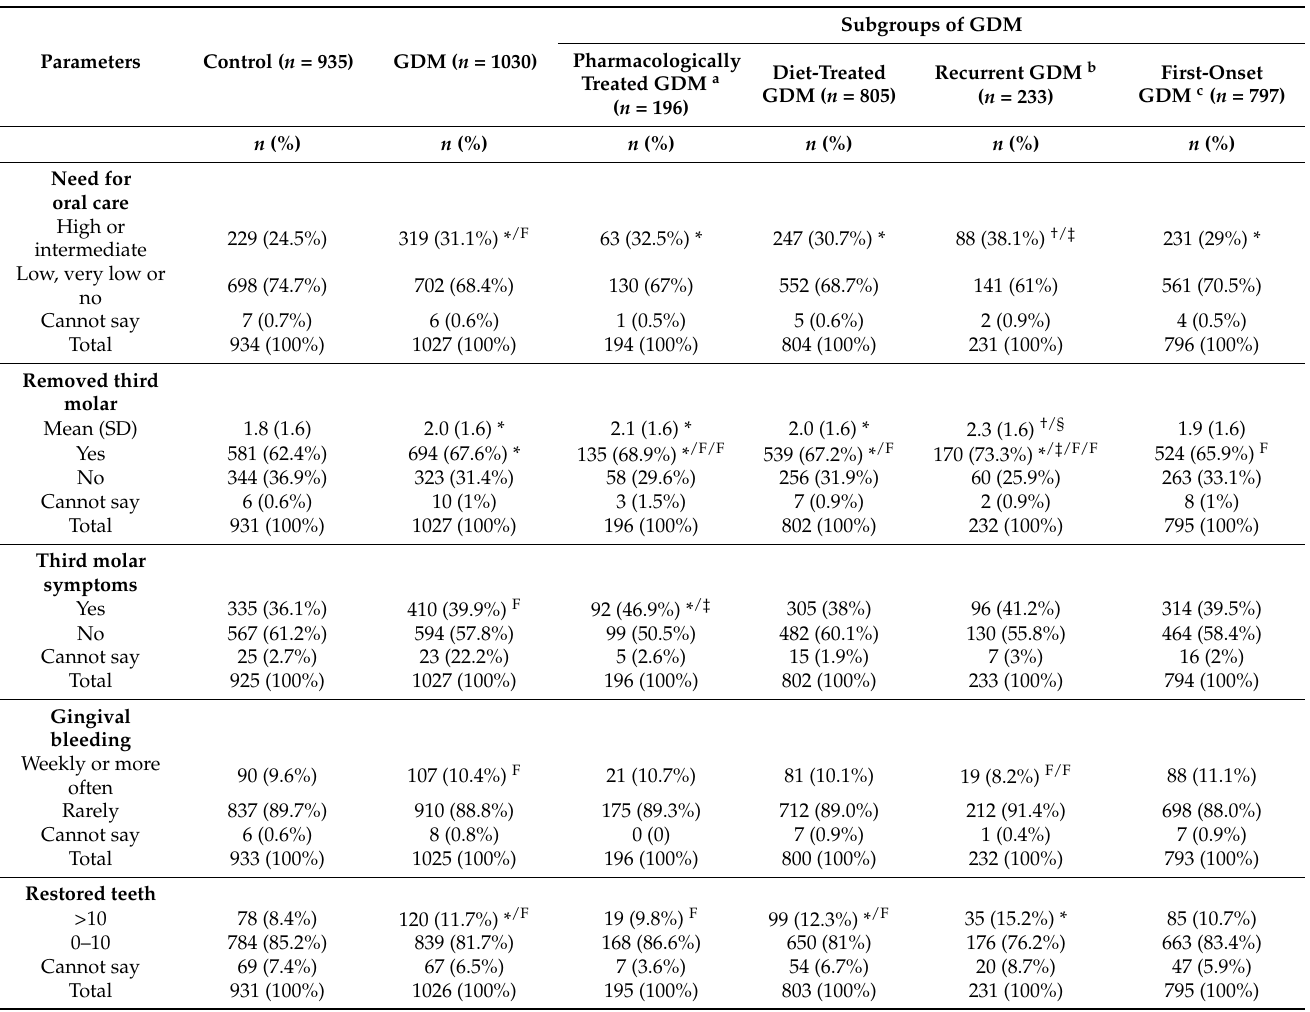
Table 4. Self-reported oral health of controls and women with gestational diabetes and its